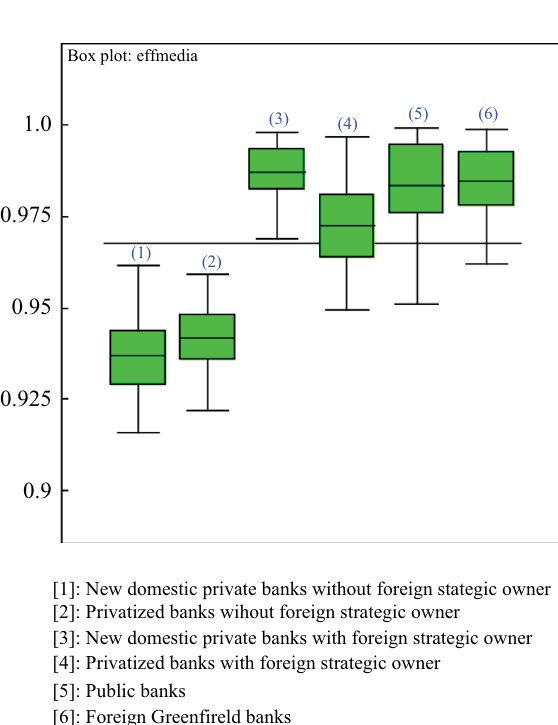
Fig. 3. Boxplot of the posterior distribution of the mean cost bank efficiency classified according to its type of ownership, distinguishing the presence/ absence of a foreign strategic owner and using the exponential model